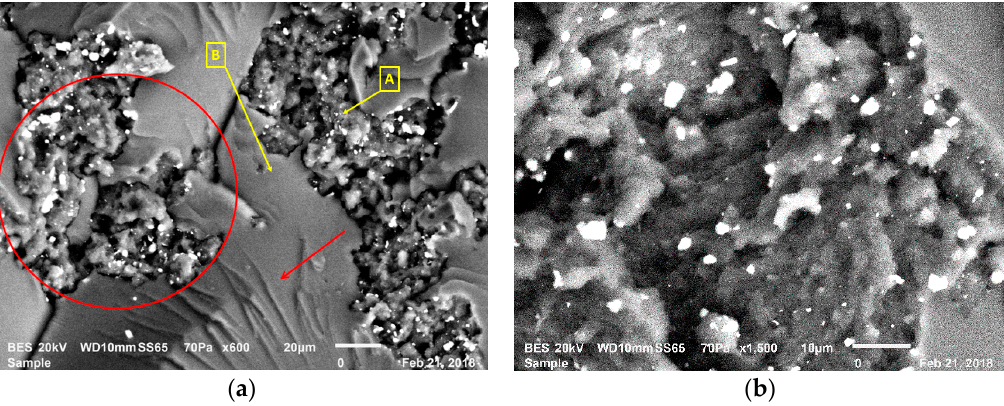
Figure 9. SEM fractography on the LRG group’s compositions: ( a ) shear band formation; ( b ) void observation.